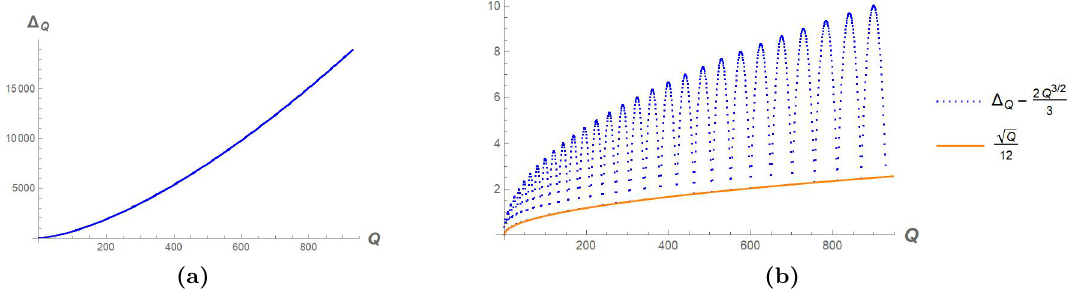
Figure 2. An illustration describing the behavior of the scaling dimension for a general value of Q . Figure 2a describes ∆ Q as a function of Q . In figure 2b, the blue dashed line shows ∆ Q − 2 √ Q as a function of Q , while the orange line describes . The points in which the blue dashed line 12 meets the orange line correspond to cases in which Q is such that equation (6.5) is satisfied with integer values of n max